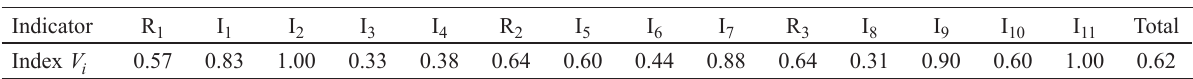
Table 5. Values of the indicators I i for the new tower alternative (Section 2) Indicator Unit Table 6. Satisfaction scores V i for requirements R i and indicators I i for the new tower alternative (Section 2) Indicator R